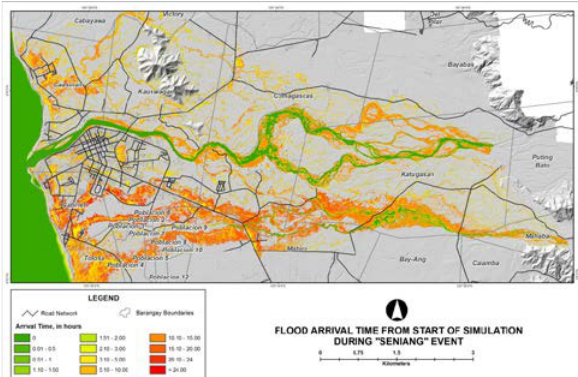
Figure 8. Map showing flood arrival times from the start of the simulation period of the Seniang event.